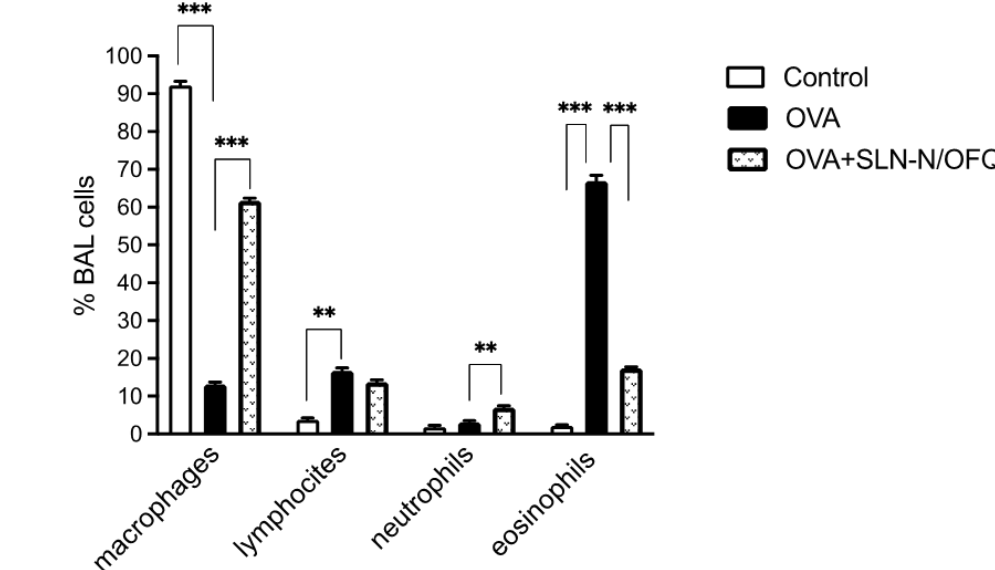
Figure 7. Effect of N/OFQ-SLNs on inflammatory cells. In the BAL fluid, samples treatment with N/OFQ-SLNs reduces significantly the percentage of eosinophils and increases the percentage of macrophages, compared to the control group. Data are means ± SEM (n = 10). ** p < 0.01, *** p < 0.001.